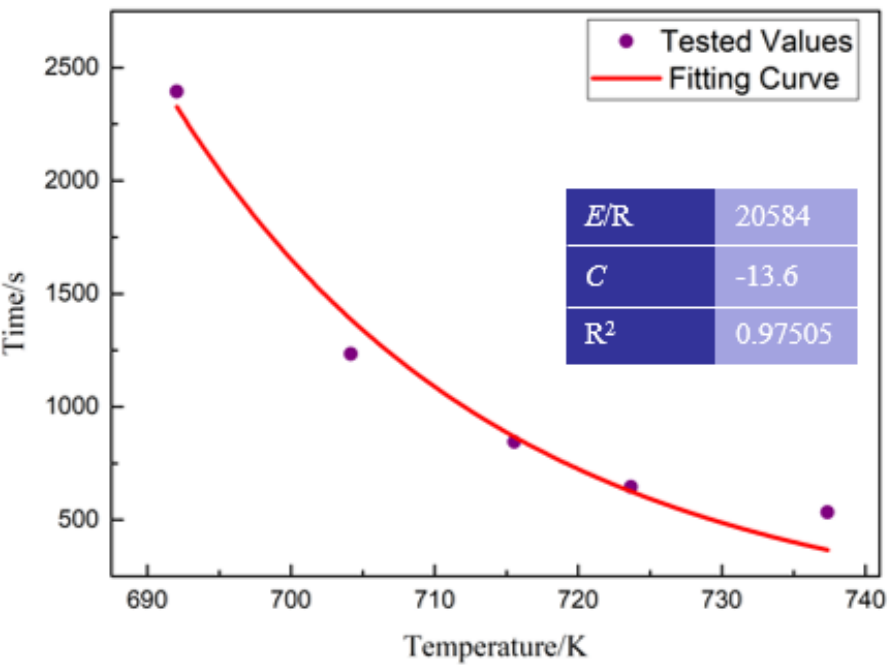
Figure 7. The fitting curve between T x and t.